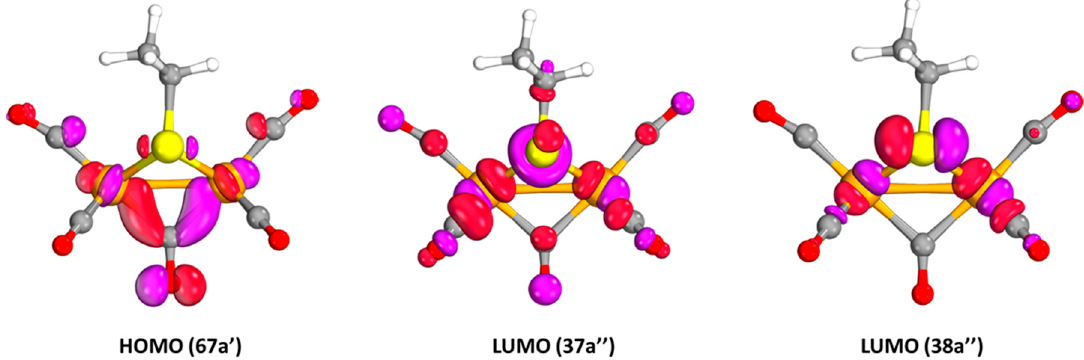
Figure 7. MO isosurfaces (0.05 a.u) for HOMO, LUMO and LUMO+1 of 1 a–CO . According to the FMO shapes and atomic orbital composition (Figure 7):